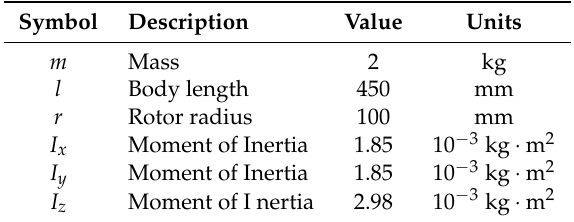
Table 1. Parameters of the quadrotor helicopter.